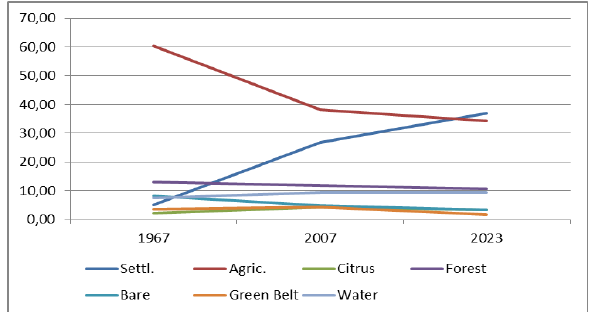
Figure 6. Percentage of Land Cover (PLAND) metrics.